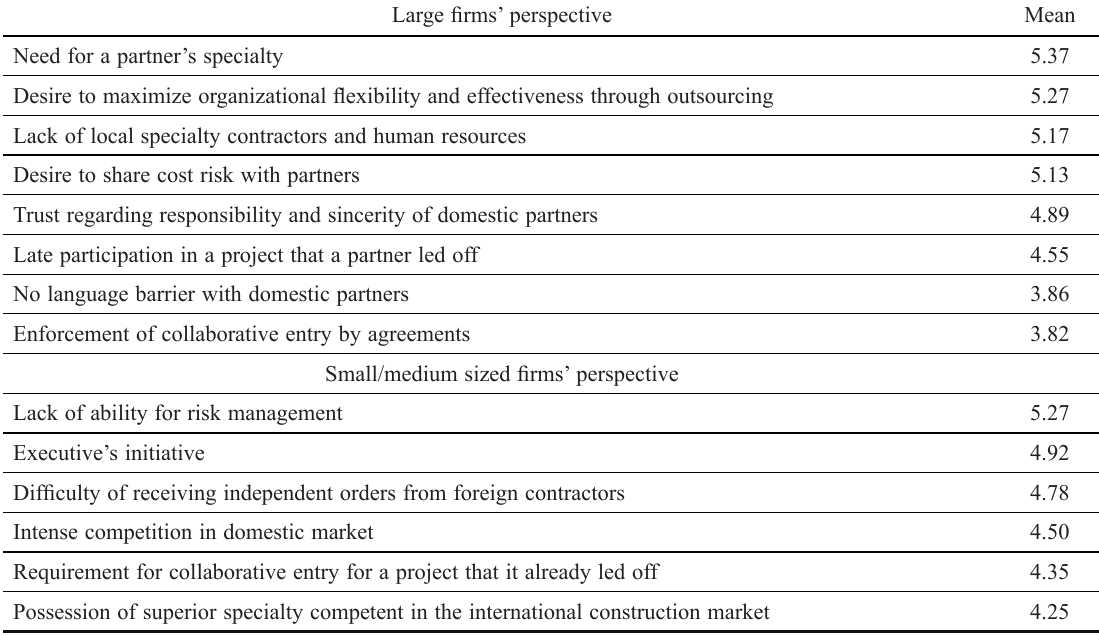
Large firms’ perspective